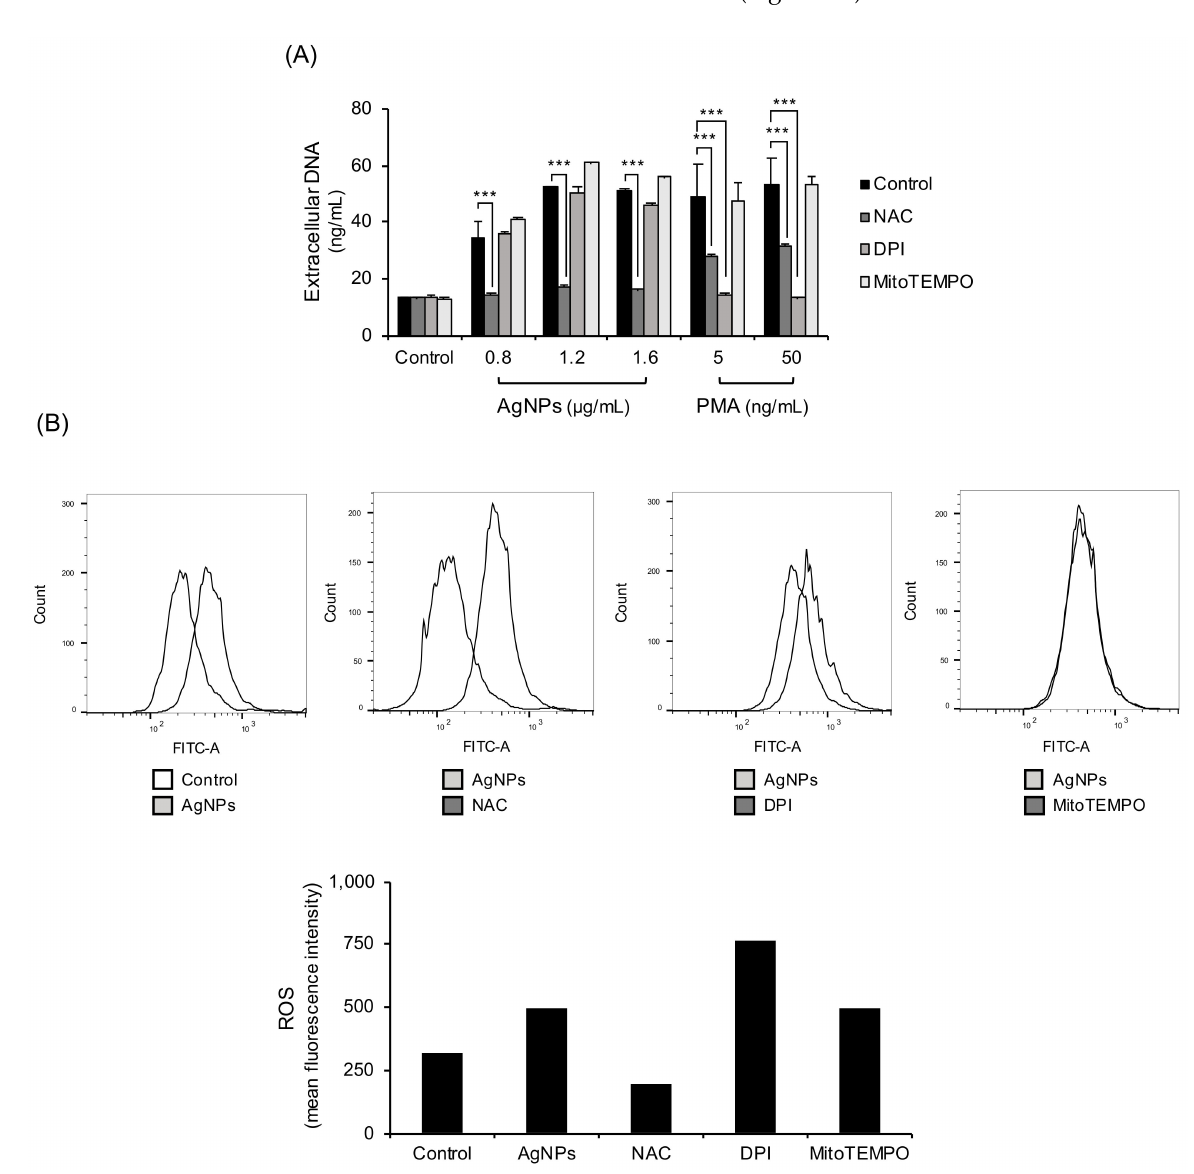
Figure 3. NET formation by 5 nm AgNPs through ROS. ( A ) Human neutrophils were pretreated with ROS inhibitors, including NAC (10 mM, 1 h) (ROS scavenger), DPI (10 µ M, 30 min) (NADPH oxidase inhibitors), MitoTEMPO (10 µ M, 1 h) (mitochondria-targeted ROS inhibitors). The samples were treated with 5 nm AgNPs or PMA for 4 h, and extracellular DNA was measured using a fluorescence microplate reader. ( B ) Human neutrophils were pretreated with CM-H 2 DCFDA and ROS inhibitors. The cells were incubated with 1.6 µ g/mL 5 nm AgNPs or 5 ng/mL PMA for 1.5 h and analyzed by flow cytometry. Two-way ANOVA was used to determine the significance (*** p < 0.001). All experiments were performed in duplicate and repeated three times with different